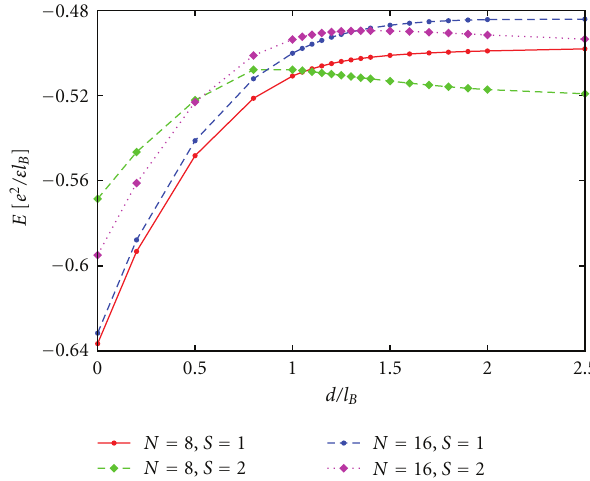
Figure 2: (color online) Ground state energies on the sphere as a function of distance for N = 8 and N = 16 electrons at the filling factor ν T = 1 and the shifts S = 1 and S =